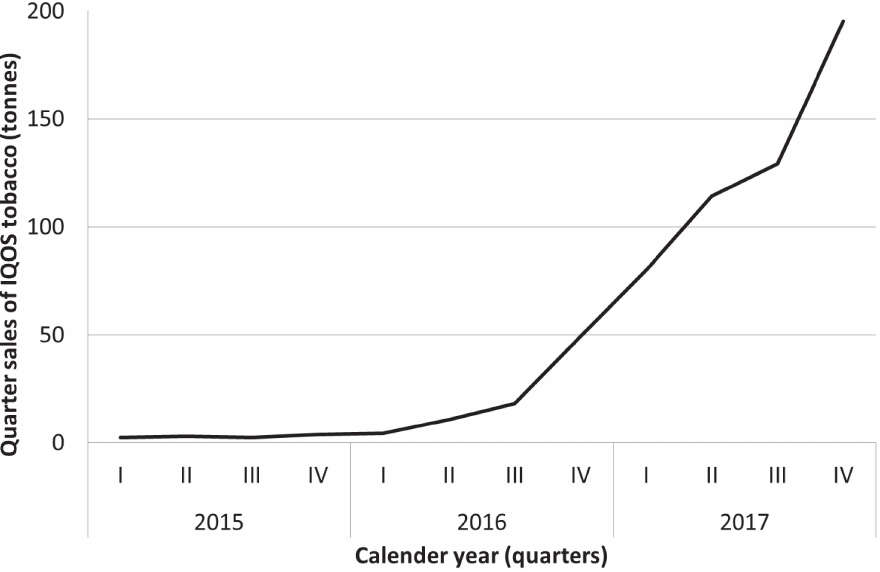
Figure 1. Quarter sales of IQOS tobacco (tonnes), Italy, 2015 –